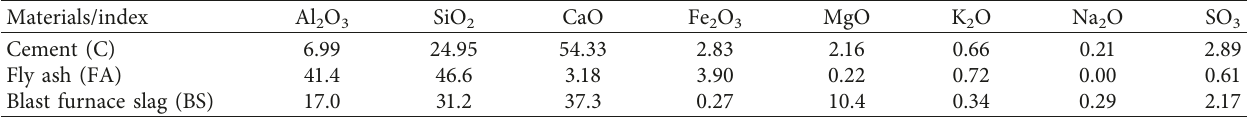
Figure 2: Tensile basic creep strain of sealed specimens can be divided from total strain. Table 1: Chemical composition of cement and mineral admixtures.